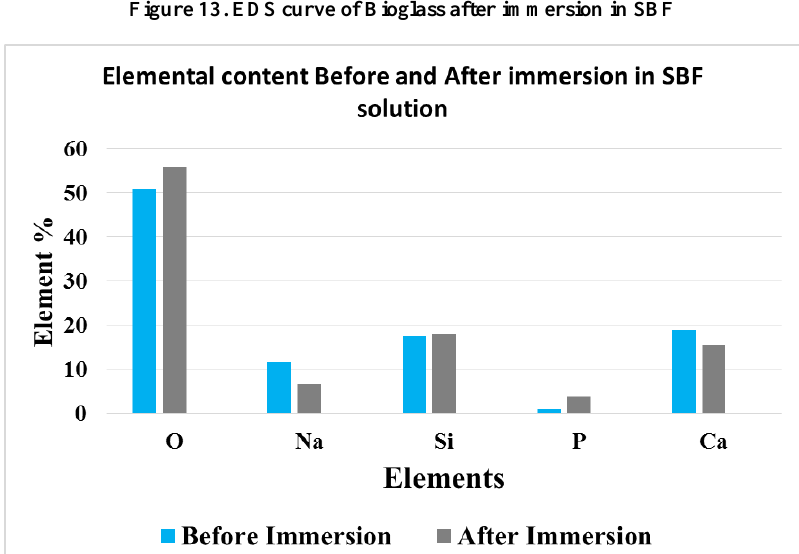
Figure 14. Quantitative Elemental